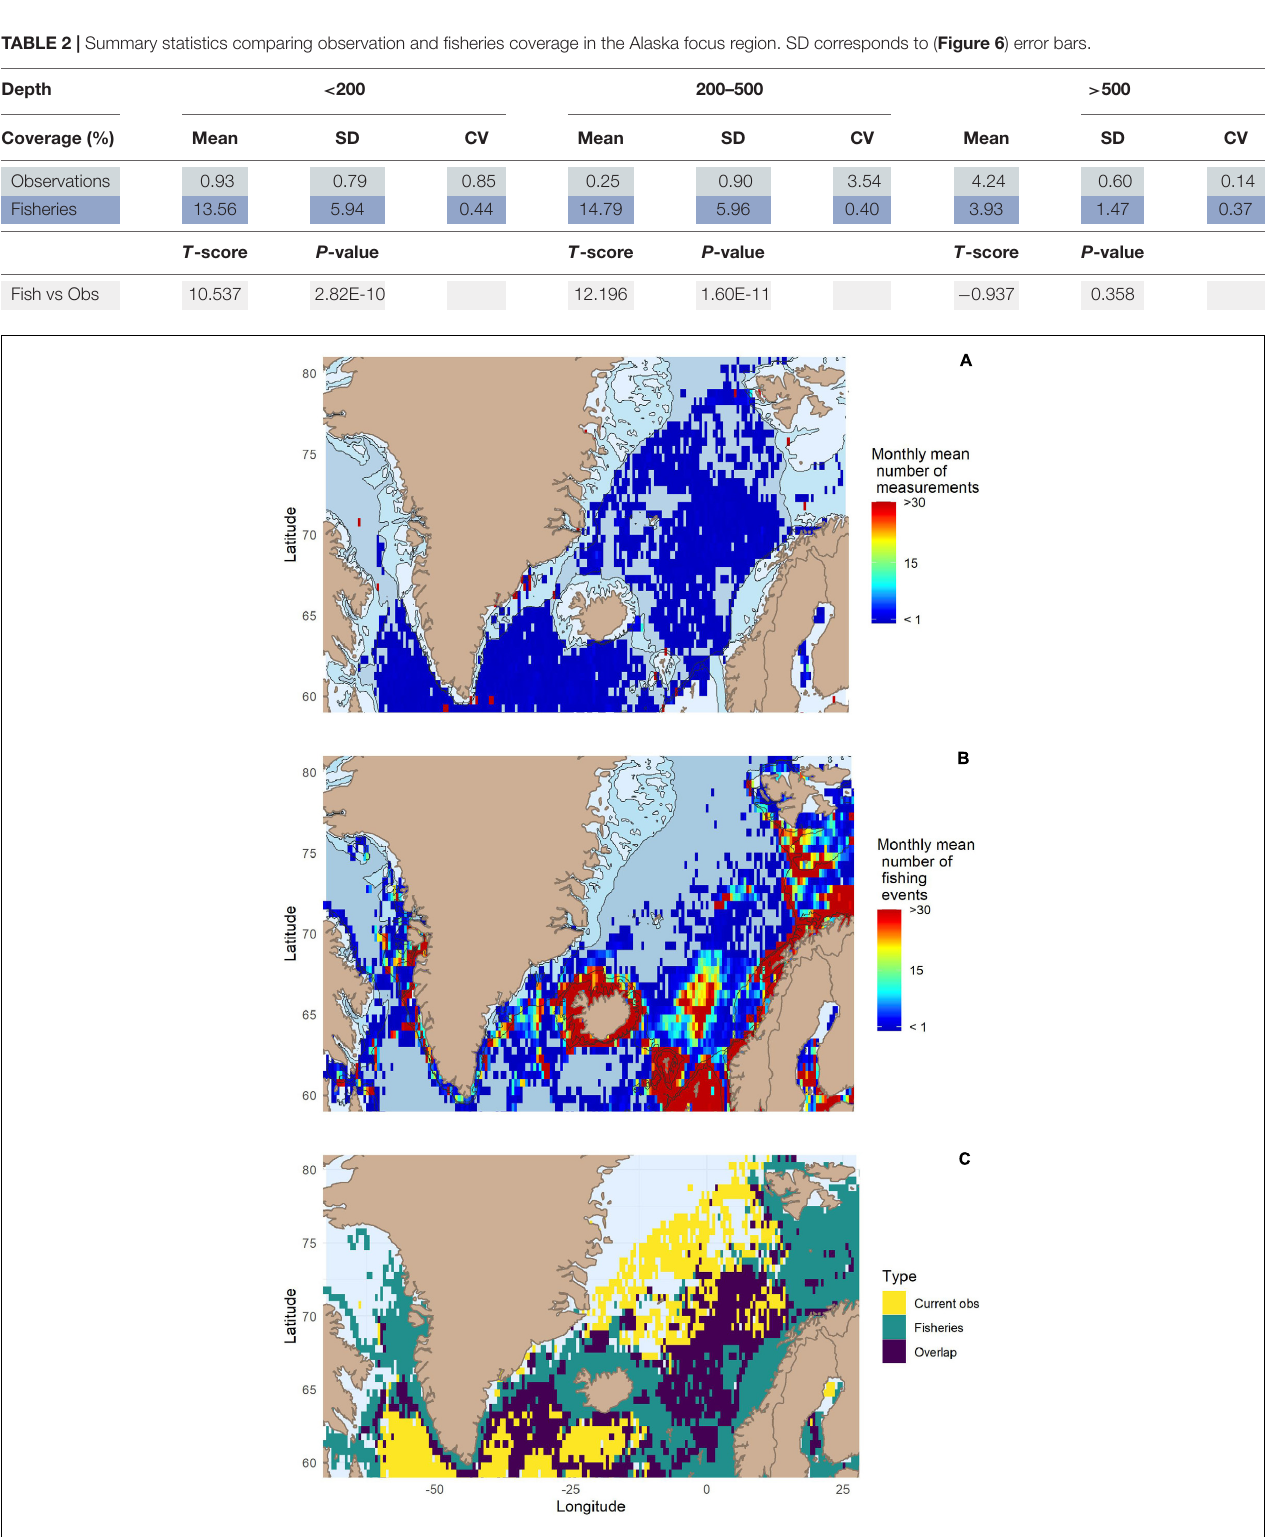
FIGURE 7 | (A) Mean monthly number of sub-surface observations for the North Atlantic region. (B) Mean monthly number of fishing events for judged suitable for potential data collection. (C) Distribution of both fishing events and ocean observations, with overlap between the two plotted in purple. Note that Northeast Greenland, above 71 ◦ North, is a national park where fishing is not allowed. In addition, much of the water around Greenland and Baffin Island is covered by sea ice for at least part of the year, making difficult both fishing and ocean observation.